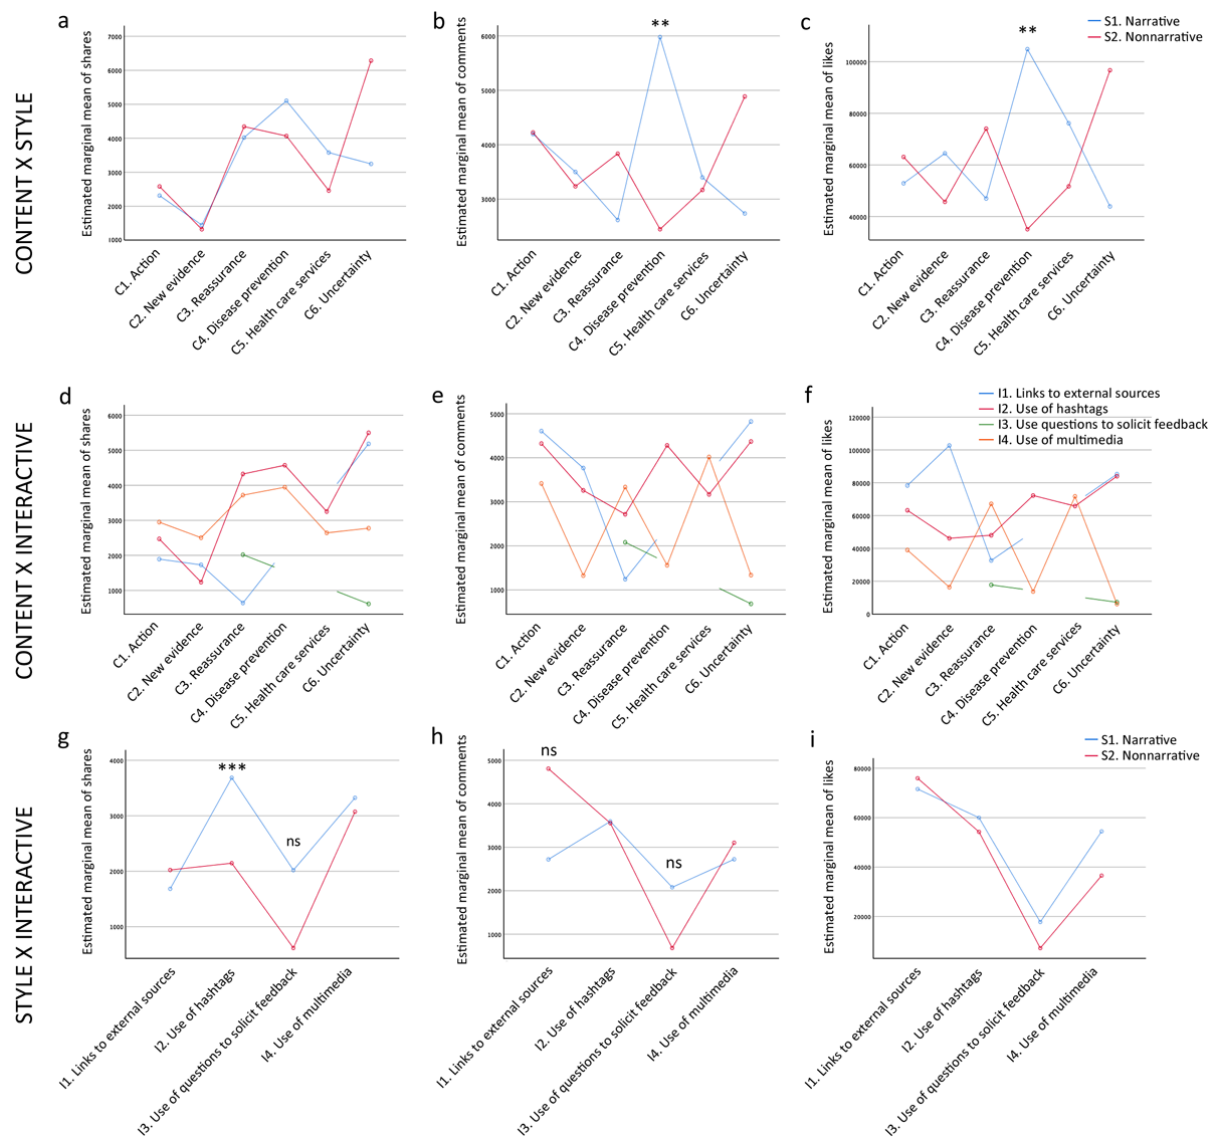
Figure 3. Simple main effects between the sub-dimensions on the number of shares, comments, and likes. Simple main effects between the sub-dimensions of content and style on the number of shares, comments, and likes (a-c). Simple main effects between the sub-dimensions of content and interactive loop on the number of shares, comments, and likes (d-f). Simple main effects between the sub-dimensions of style and interactive loop on the number of shares, comments, and likes (g-i). ** P <.01, *** P